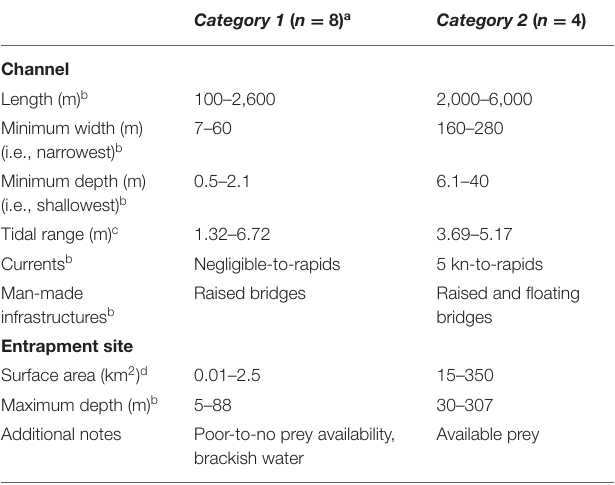
TABLE 3 | Characteristics of the sites where killer whales became entrapped in the North Pacific and North Atlantic Oceans in 1949–2019 for cases assigned to Categories 1 and 2